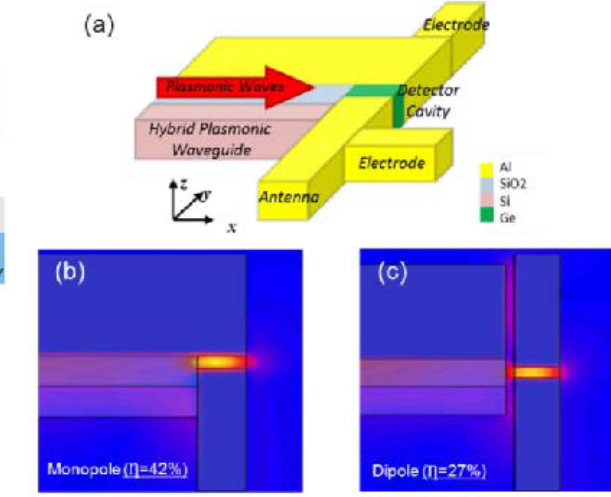
Figure 14: (a) Schematics of a monopole antenna waveguide pho- todetector, whose nanocavity is formed by coupling a plasmonic hy- brid waveguide with a monopole antenna. (b) Simulated power flow intensity inside the waveguide and the nanocavity. (c) The power flow inside a photodetector with dipole antenna is also shown, where “leaky power” in the gap lowers the coupling eflciency. Fig- ures with reprint permission from Ref. [231] ©2009